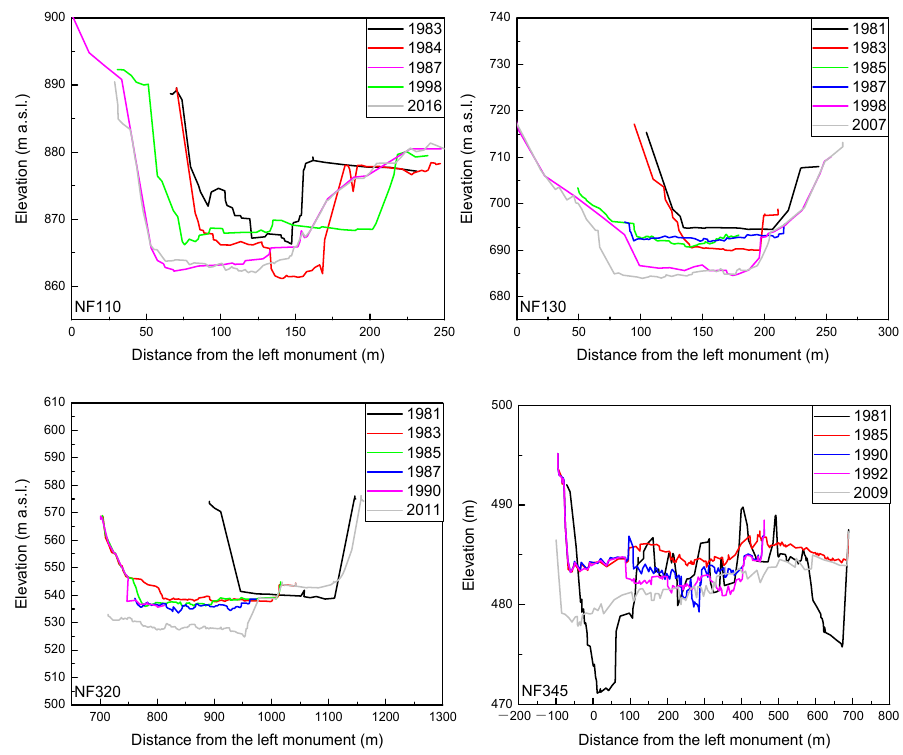
Figure 8. Time series of profiles for cross sections.